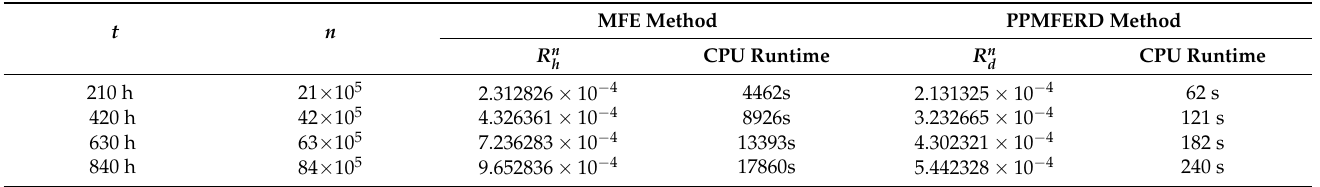
Table 2. The comparison of CPU runtime and errors for the MFE solutions and the PPMFERD solutions.